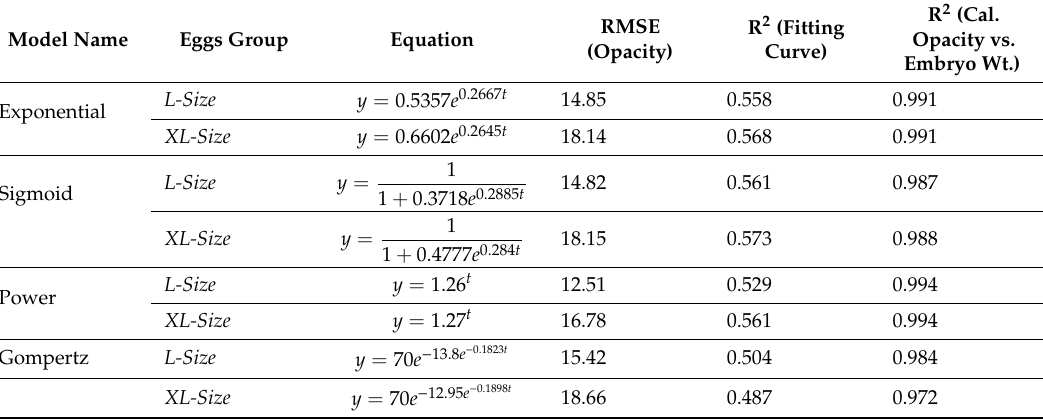
Table 2. Equation, parameters and performances of various growth models with respect to opacity and embryo